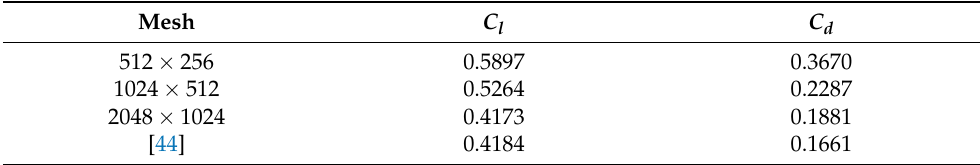
Table 1. Influence of mesh refinement: mean coefficients C l and C d , obtained in the interval time t ∗ = [ 70 : 100 ] , for α = 10 ◦ .